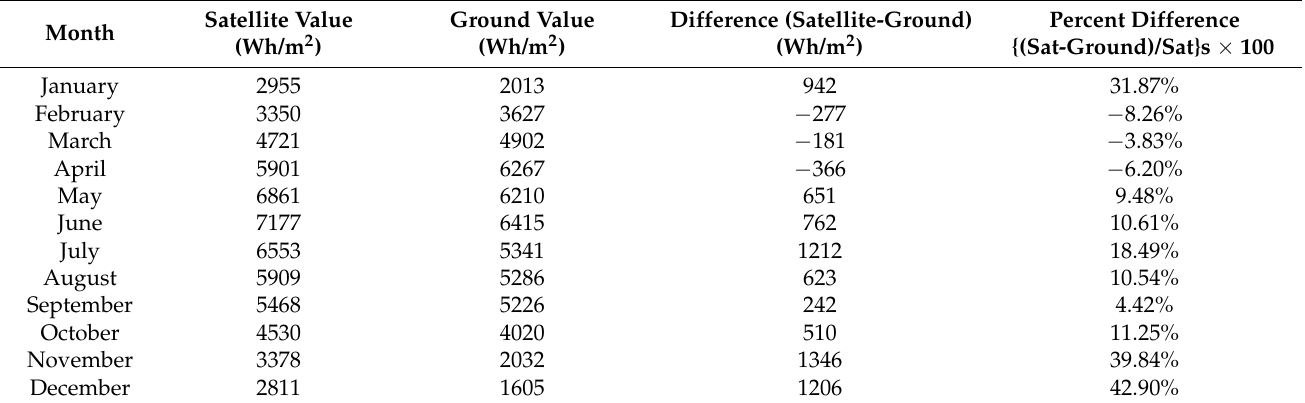
Figure 5. Comparison of ground-based GHI with satellite-based GHI. Table 3. Comparison of ground-based GHI with satellite-based